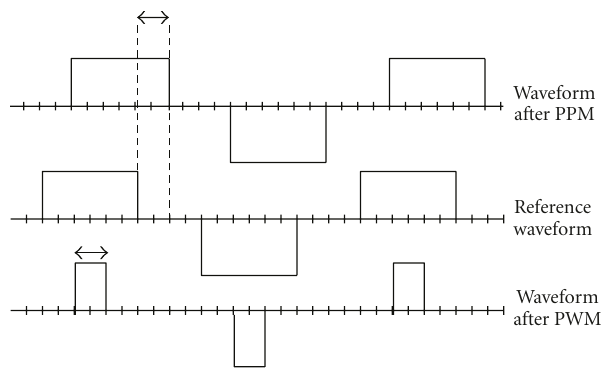
Figure 2: Demonstrating PWM (amplitude modulation) and PPM (phase modulation) concept. Edges occur on the digital timing grid.